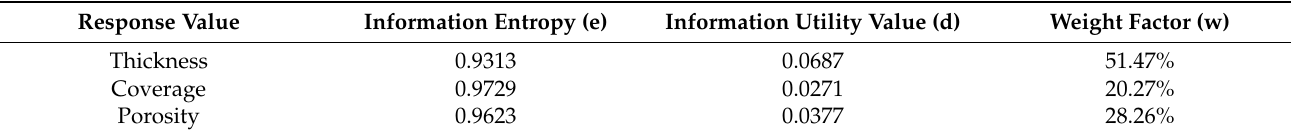
Table 3. Entropy method to calculate the weight